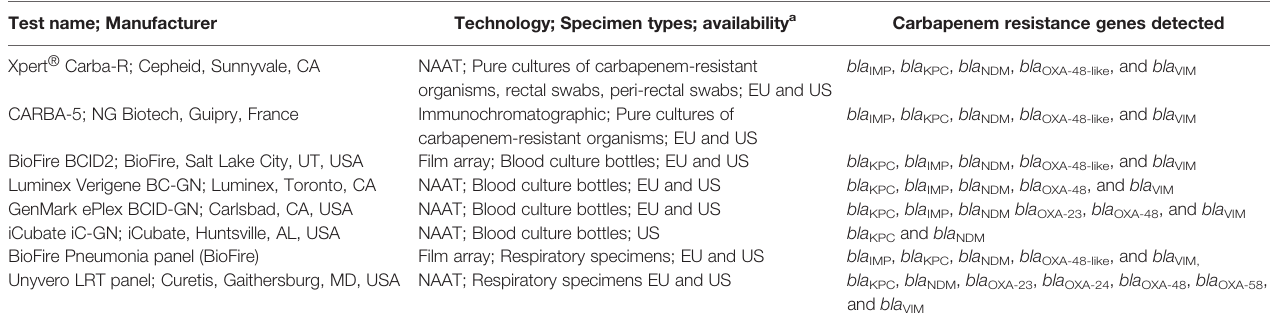
TABLE 2 | Examples of molecular and immunochromatographic diagnostic tests to detect and differentiate carbapenem resistance genes in pure culture colonies or clinical specimens. Test name;